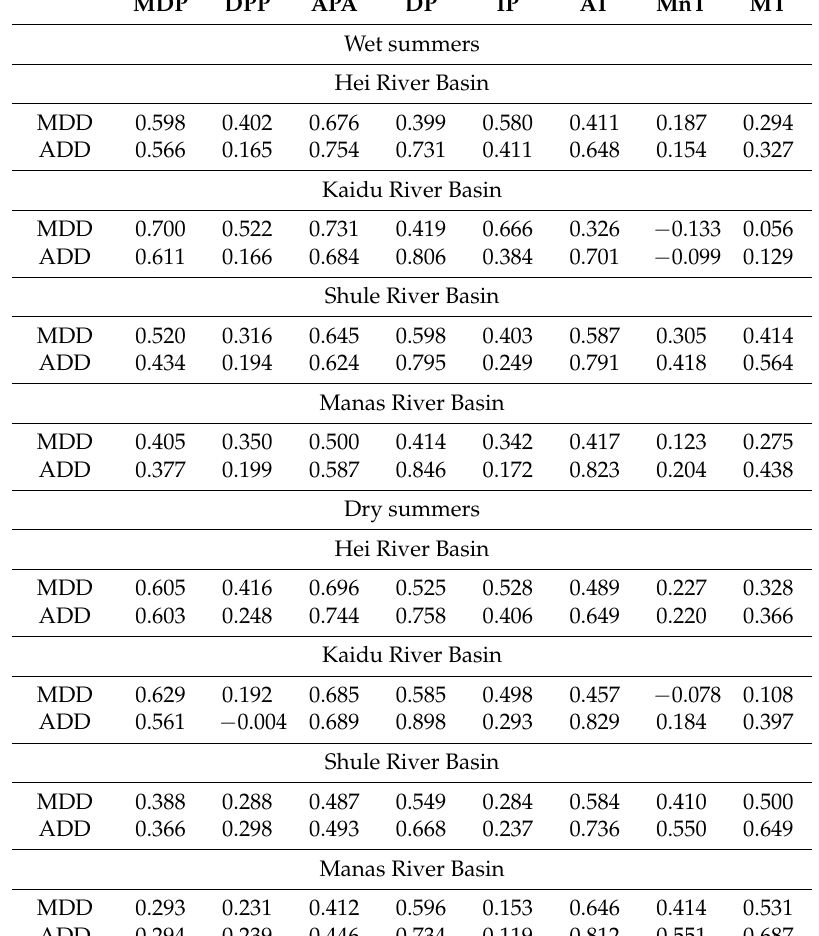
Table 7. Standardized coefficients of linear regression equations on the relationships of runoff indices—MDD and ADD—with precipitation and temperature indices during wet and dry